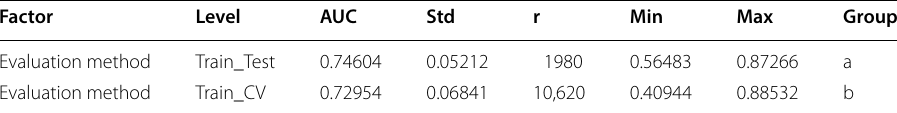
Table 6 Tukey’s HSD test results for evaluation methods